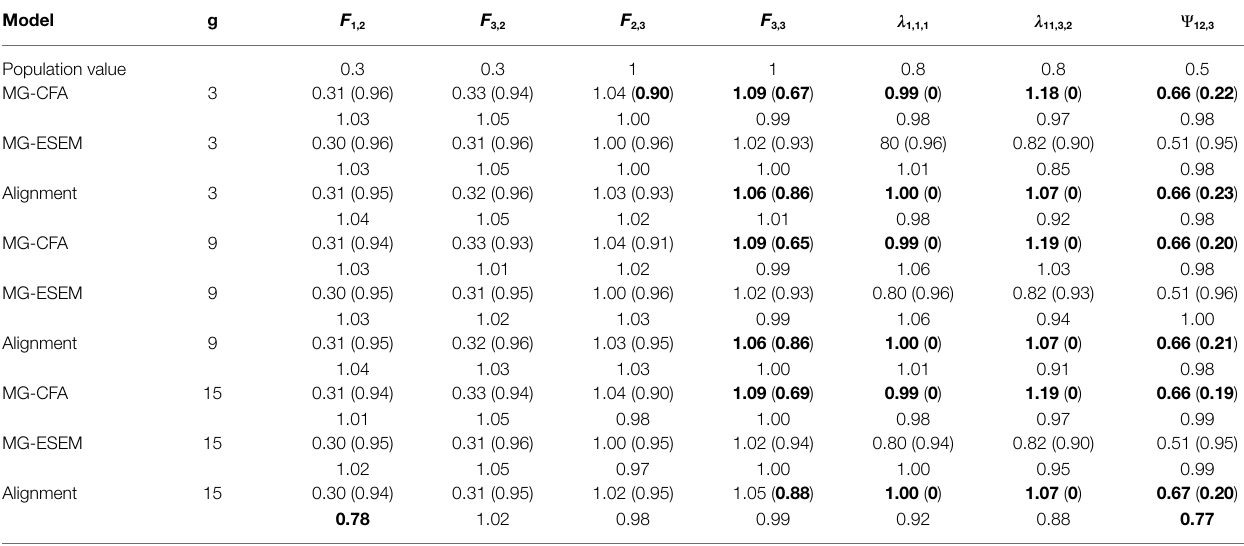
TABLE 5 | Parameter estimates, coverage rates and ratios of average standard error to standard deviation of multiple-group CFA, multiple-group ESEM and alignment when the factor loading matrix is 2 L ( N g = 1,000). Model